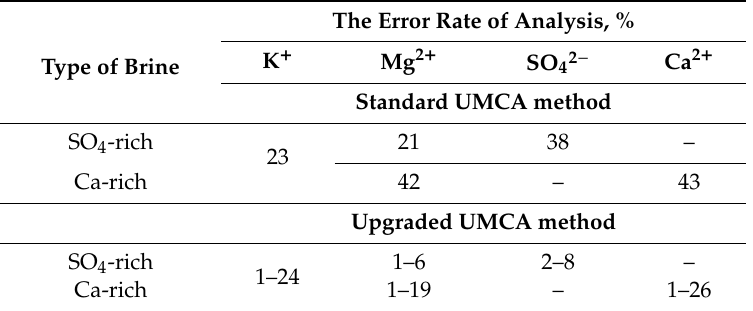
Table 1. Analytical error rates under the ultramicrochemical analyses (UMCA) method before and after method upgrading, calculated for the analyses of the main components in Ca-rich and SO 4 -rich brines. The error rates were calculated under the upgraded UMCA method, in respect of the data obtained from the sedimentary brine studies. The primary inclusions located strictly along separate zones of the bottom chevron halite crystals had been tested previously. Halite samples come from the Ordovician salt of the Ordos Basin [4], and also from the Cretaceous salt deposits of the Sakon Nakhon Basin (Laos) and the Badenian salt deposit from Poland (unpublished data). The Error Rate of Analysis, % K + Mg 2 Type of Brine